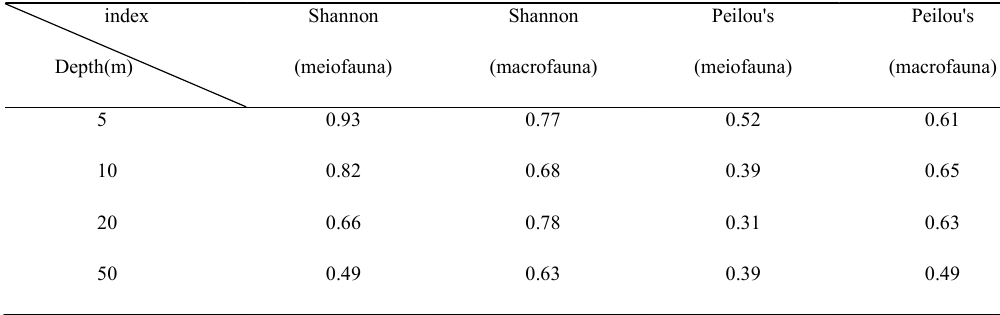
Table 6: Shanon and Peiole index meiofauna and macrofaunain different depths in the southern Caspian Sea from Behshahr to Ramsar